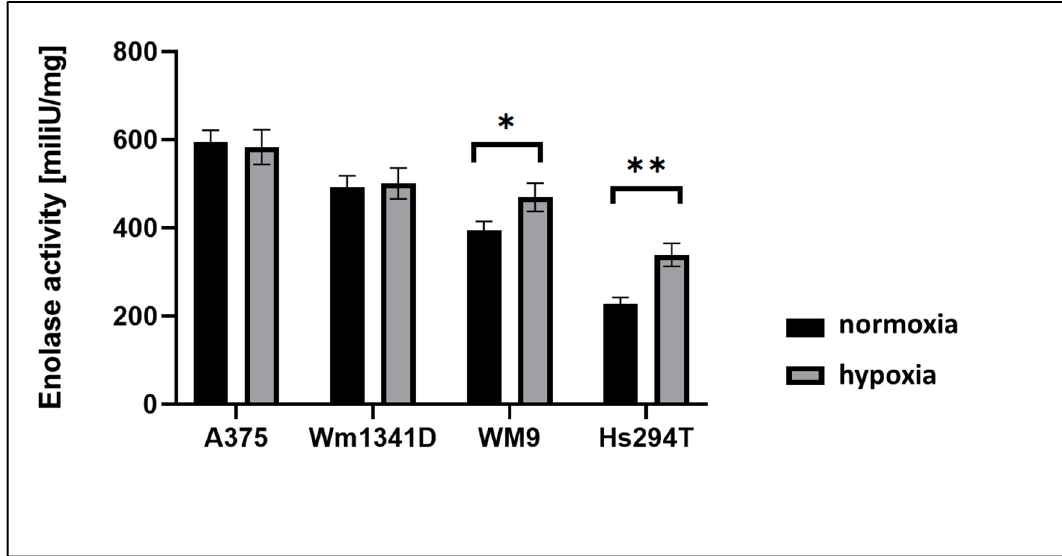
Figure 3. The enolase activity in protein lysates prepared from A375, Hs294T, WM1341D, and WM9 melanoma cells cultured under normoxia or hypoxia. Bars represent mean values (n = 4) ± standard error of the mean (SEM). The significance level was set at p = 0.05–0.01 (*), p = 0.01–0.001 (**).